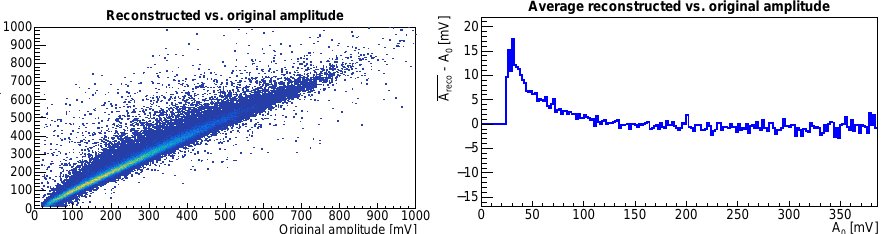
Figure 8. ( Left ) All events based on their reconstructed amplitude value and the original one ( Right ) Difference between the average value of the reconstructed amplitude A reco and the original value A 0 for each original value A 0 , divided into 2 mV bins. It can be observed that for small amplitudes the reconstructed value is higher than the original